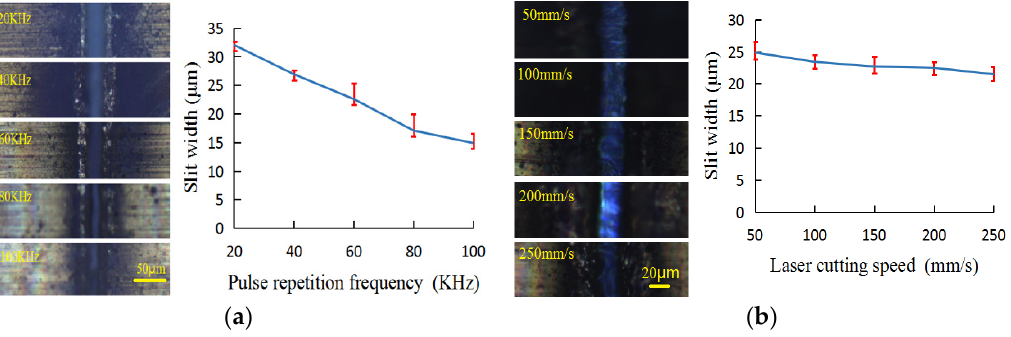
Figure 5. ( a ) Slitting at different pulse repetition rates. ( b ) Slit cutting at different cutting speeds. With the increase of frequency, the thermal effect decreases, and there is a nonlinear inverse relationship between pulse repetition frequency and slit width. The pulse repeti- tion frequency increases from 20 to 100 KHz, and the slit width decreases from 32 to 15 μ m. When the frequency reaches a certain value, the slit width changes very little. With the increase of laser pulse repetition frequency, the flatness of the incision becomes worse, while the width of the incision and the width of the heat affected zone decrease, which is caused by the influence of pulse repetition frequency on the peak power of the laser. When selecting the pulse repetition frequency, it is necessary to reduce the influence of thermal effect as much as possible under the premise of ensuring the laser cutting effect. 2. Laser cutting speed Laser cutting speed is also one of the important factors affecting the effect of laser cutting, directly affecting the width of the incision and surface roughness. In this experi- ment, the cutting speed of laser marking machine ranges from 0 to 7000 mm/s. Due to the low absorption rate of ultraviolet laser on copper foil, the action time between laser and copper foil is shortened due to the excessive cutting speed, so the efficiency of high-speed processing is low. In order to explore the impact of laser cutting speed on notch quality, pulse repetition frequency of 80 KHz was selected for the test. Figure 5b shows the notch of copper foil under low-speed laser cutting. When the cutting speed increases from 50 to 250 mm/s, the cut width decreases from 25 to 20 μ m. Laser cutting speed has little effect on the slit width. When the cutting speed is slow, the action time of laser energy in the incision will be prolonged, and the effective spot area and slit width will increase. At the cutting speed of 50 mm/s, a large amount of material accumulation was ob- served on both sides of the incision, which was caused by excessive ablation due to the slow cutting speed, which made the incision larger and the edge rough. Therefore, on the premise of ensuring that the cutting through, choose a larger cutting speed as far as pos- sible. In addition, when the cutting speed is greater than 1000 mm/s, the energy obtained per unit area of the workpiece surface is reduced, and the situation cannot be cut through. Only when the processing times are increased to more than 40 times, can the obvious in- cision be seen, but this will undoubtedly greatly reduce the processing efficiency. When the cutting speed is further increased to 5000 mm/s, the laser cannot completely cut through the copper foil, and a series of continuous circular holes with the diameter of about 15 μ m are generated on the copper foil. The spacing of adjacent holes increases with the increase of cutting speed. To sum up, for the laser cutting of copper foil, the quality of the incision is inseparable from the laser energy. When the input energy is large, it is easy to obtain a wider incision, accompanied by a more serious thermal effect. When the cutting speed increases, the ox- idized area on both sides of the cut decreases significantly. Increasing the cutting speed can reduce the oxidation on the metal surface to a certain extent. When the cutting speed is too fast, the width of the cut is reduced accordingly. At this time, it is difficult to cut through the copper foil simply by increasing the processing times, but it is easy to cause the accumulation of heat on the surface of the material to cause serious deformation of the